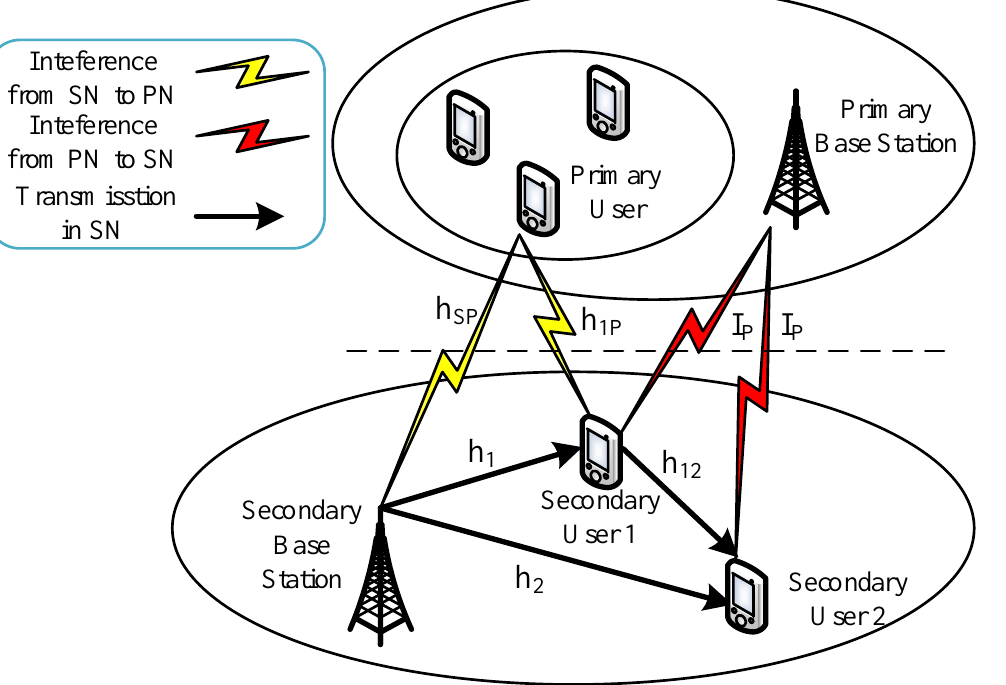
Figure 1. System model of cognitive radio(CR) and section scheme of OMA/non-orthogonal multiple